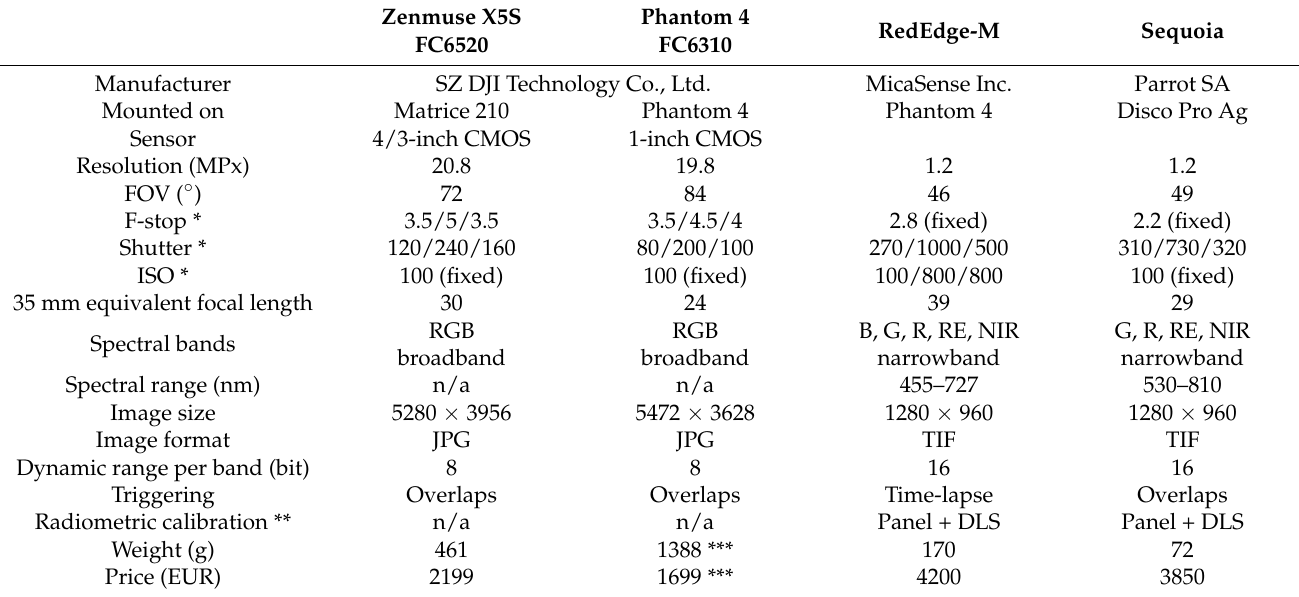
Table 1. Specifications of the used UAV-mounted